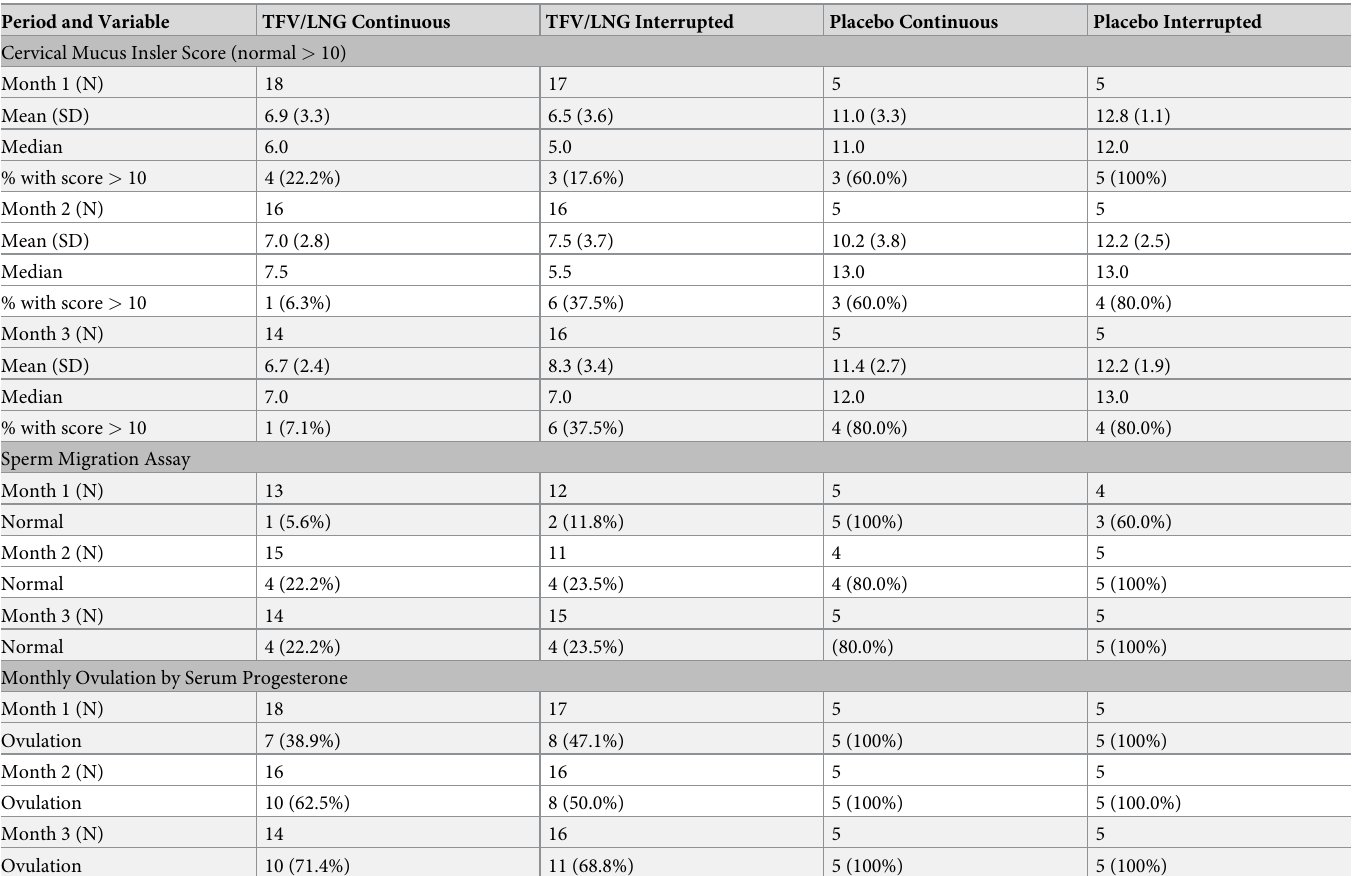
Table 7. Pharmacodynamic surrogates of levonorgestrel activity.